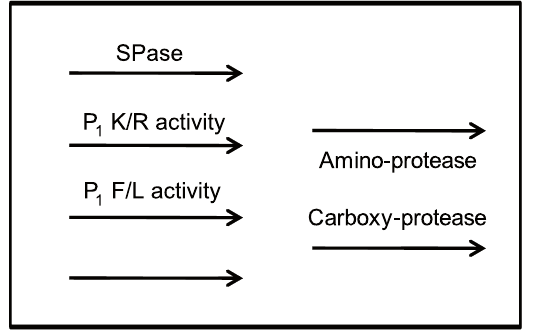
Figure S2 Identification of the SF 328–336 ligand in cell extracts by mass spectrometry. (PDF) Figure S3 Identification of the LMMP5 249–262 ligand in cell extracts by mass spectrometry. (PDF) Figure S4 HLA-B*2705 stabilization assay with synthet- ic ligands. (PDF) Figure S5 Length distribution of naturally processed peptides presented by HLA class I molecules in a TAP- deficient T2 cell line versus TAP-dependent ligands. (PDF) Figure S6 Representative nested set peptides of ligands identified by mass spectrometry. (PDF) Figure S7 Naturally processed peptides from MRCL2, b -actin, and glyceraldehyde 3-P dehydrogenase proteins identified by mass spectrometry. (PDF) Table S1 Summary of HLA-A2 ligands identified by mass spectrometry analysis. (PDF) Table S2 Summary of HLA-B27 ligands identified by mass spectrometry analysis. (PDF) Table S3 Summary of HLA-B51, or -Cw1 ligands identified by mass spectrometry analysis. (PDF) Table S4 Summary of HLA ligands clustered by protein origin. (PDF) Table S5 Subcellular location of proteins with TAP- independent ligands presented by HLA-A2, -B27, and - B51 or –Cw1. Table S6 Summary of HLA ligands identified and coverage protein from individual protein. Table S7 Summary of predominant cleavaged residues by peptidases in TAP-independent